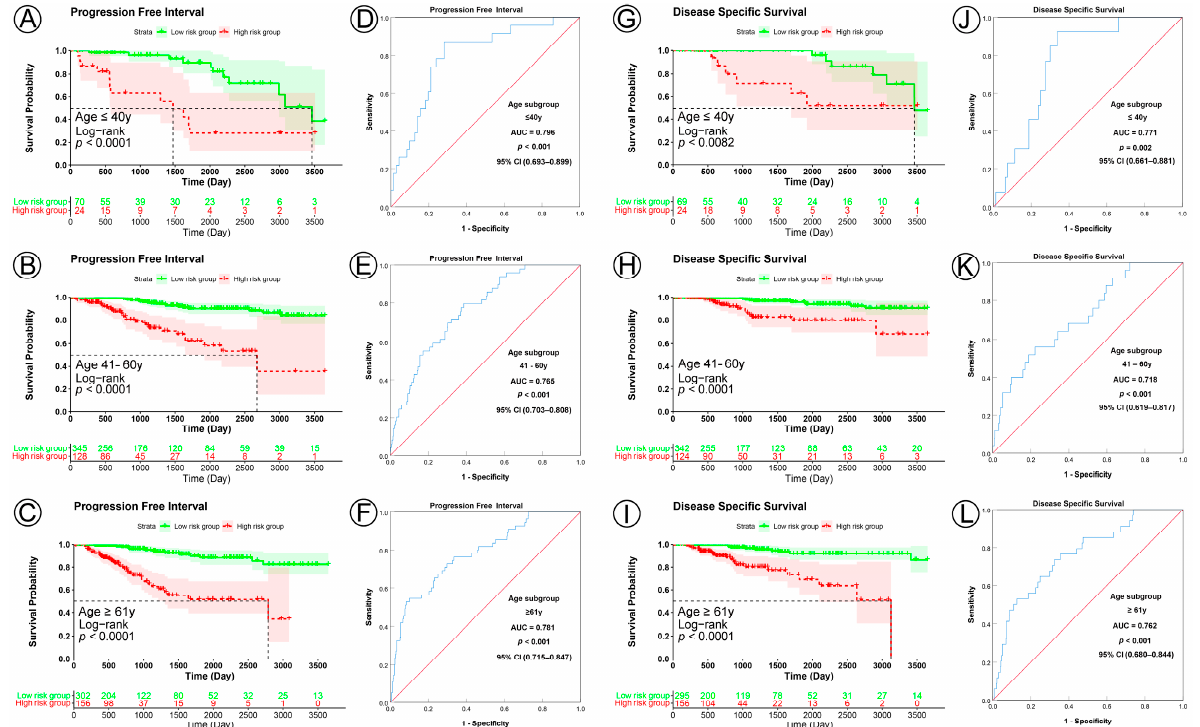
Figure 4. KM and ROC curve analyses of patients stratified by age. ( A – C , G – I ), KM curves of PFI and DSS for high and low-risk groups in the ≤ 40-year, 41–60-year, and ≥ 61-year subgroups. ( D – F , J – L ), ROC analysis showed the sensitivity and specificity of prognostic signature for predicting PFI and DSS for high and low-risk groups in the ≤ 40-year, 41–60-year, and ≥ 61-year subgroups. In the analyses of tumor size subgroups, KM curves also showed that patients in the low-risk group had a significantly better prognosis for PFI, DSS, and OS than those in the high-risk group (PFI, T1 subgroup, p < 0.0001, T2 subgroup, p < 0.0001, T3–T4 subgroup, p < 0.0001; DSS, T1 subgroup, p = 0.0026, T2 subgroup, p < 0.0001, T3–T4 subgroup, p < 0.0001; OS, T1 subgroup, p = 0.0095, T2 subgroup, p < 0.00012, T3–T4 subgroup, p < 0.0012) (Figure 5A–C,G–I; Figure S1G–I). ROC analysis demonstrated that the prognostic signature had good sensitivity and specificity for predicting PFI, DSS, and OS in all three tumor size status subgroups (PFI, T1 subgroup, AUC = 0.756, 95% CI 0.661–0.850, p < 0.001, T2 subgroup, AUC = 0.758, 95% CI 0.700–0.816, p < 0.001, T3–T4 subgroup, AUC = 0.785, 95% CI 0.702–0.867, p < 0.001; DSS, T1 subgroup, AUC = 0.731, 95% CI 0.589–0.873, p = 0.005, T2 subgroup, AUC = 0.715, 95% CI 0.641–0.789, p < 0.001, T3–T4 subgroup, AUC = 0.789, 95% CI 0.684–0.894, p < 0.001; OS, T1 subgroup, AUC = 0.650, 95% CI 0.535–0.766, p = 0.017, T2 subgroup, AUC = 0.602, 95% CI 0.531–0.672, p < 0.006, T3–T4 subgroup, AUC = 0.667, 95% CI 0.561–0.772, p < 0.003) (Figure 5D–F,J–L; Figure S1J–L).